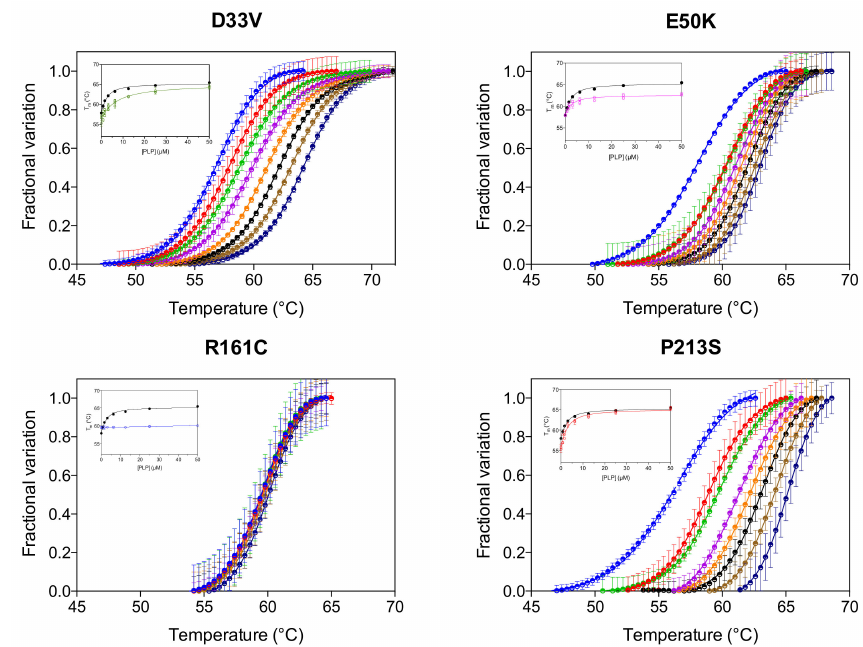
Figure 3. PLP binding at the active site. DSF measurements with PNPO variants in the presence of different PLP concentrations. Fluorescence change is expressed as fractional variation as a function of temperature. The experiment was carried out using 2 µ M enzyme and different PLP concentrations (0, 0.78, 1.56, 3.13, 6.25, 12.5, 25 and 50 µ M), which are displayed in different colours from light blue (0 µ M) to dark blue (50 µ M). Thermal denaturation data are fitted to the Boltzmann equation to obtain melting temperatures. Each curve is the average of three independent experiments with standard error bars. In the insets, the saturation curves obtained by plotting the melting temperatures as a function of the PLP concentration are shown. The saturation curve of the wild type enzyme (in black) is reported as reference. Data were analysed using Equation (1) to estimate dissociation constant values (K D2 ) (reported in Table